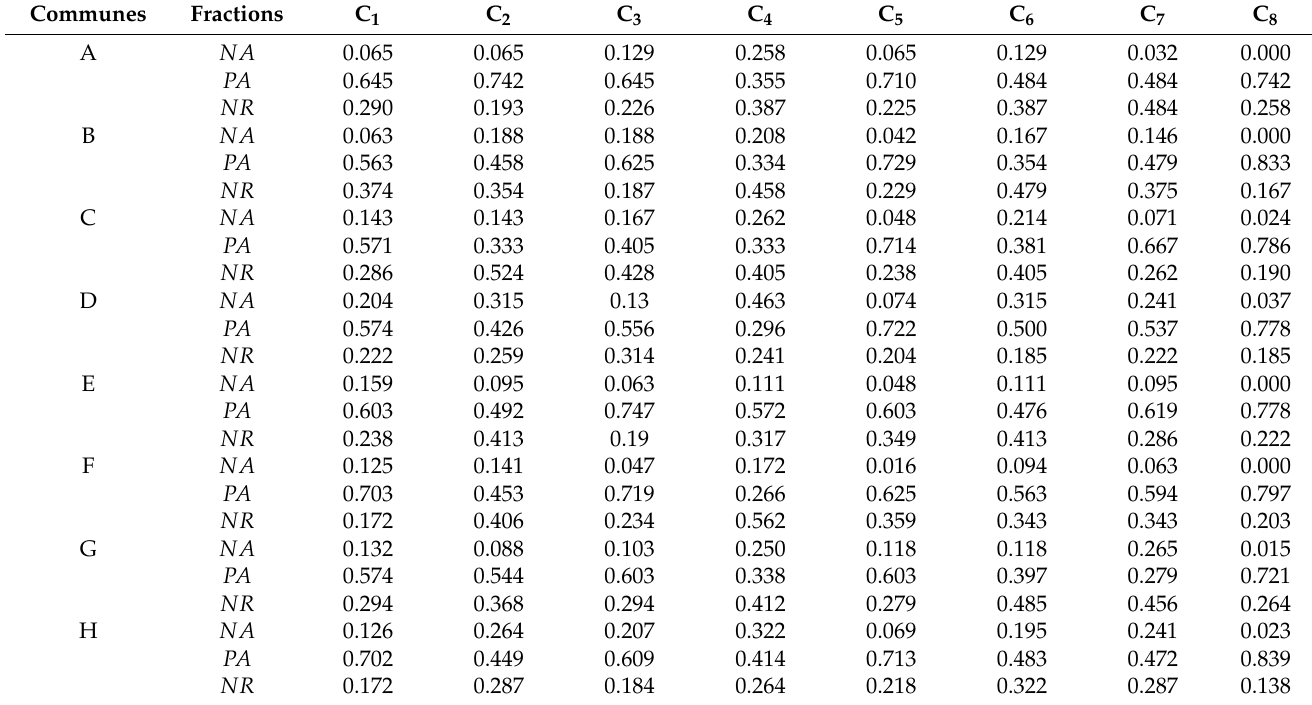
Table 3. Fractions of respondents who assessed the communes negatively ( NA ), positively ( PA ), and had no opinion ( NR ) in terms of the partial criteria. Communes